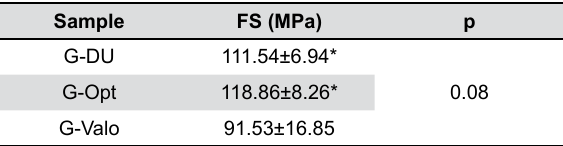
in Figure 7. The given SS curves represent the